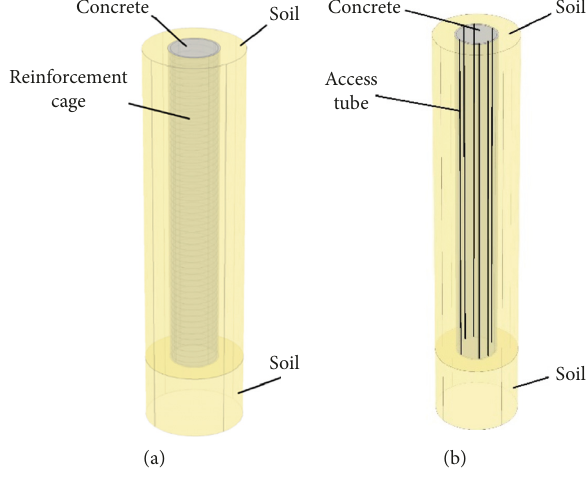
Figure 2: Shaft-soil model.